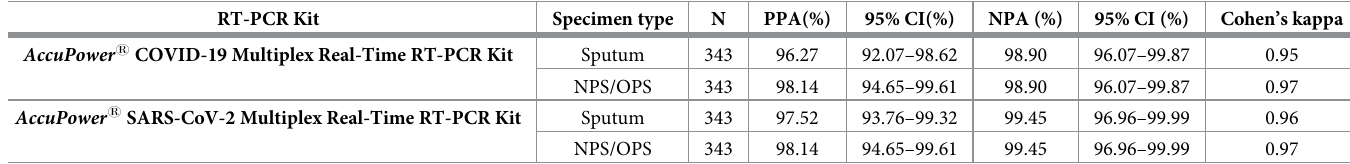
Table 5. Clinical agreement evaluation results for the AccuPower 1 kits with STANDARD ™ M nCoV Real-Time Detection kit. RT-PCR